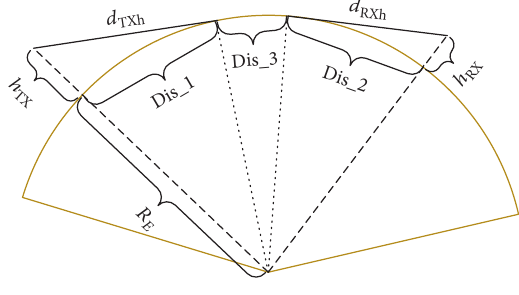
Figure 22: Ground-wave propagation over a smooth spherical